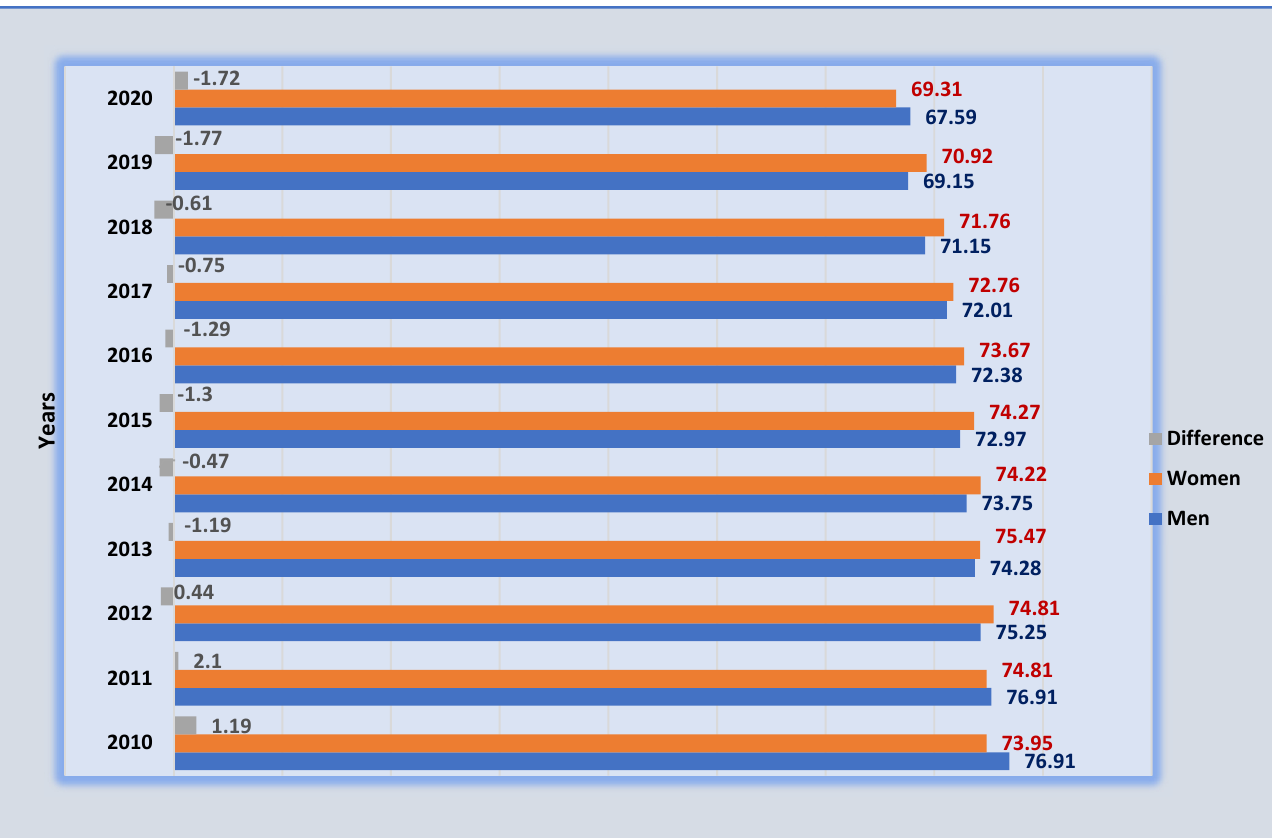
Figure 4. Activity rates of separated or divorced people by sex (percentages). Source: Authors with data from the Statistics National Institute ( Instituto Nacional de Estadística .